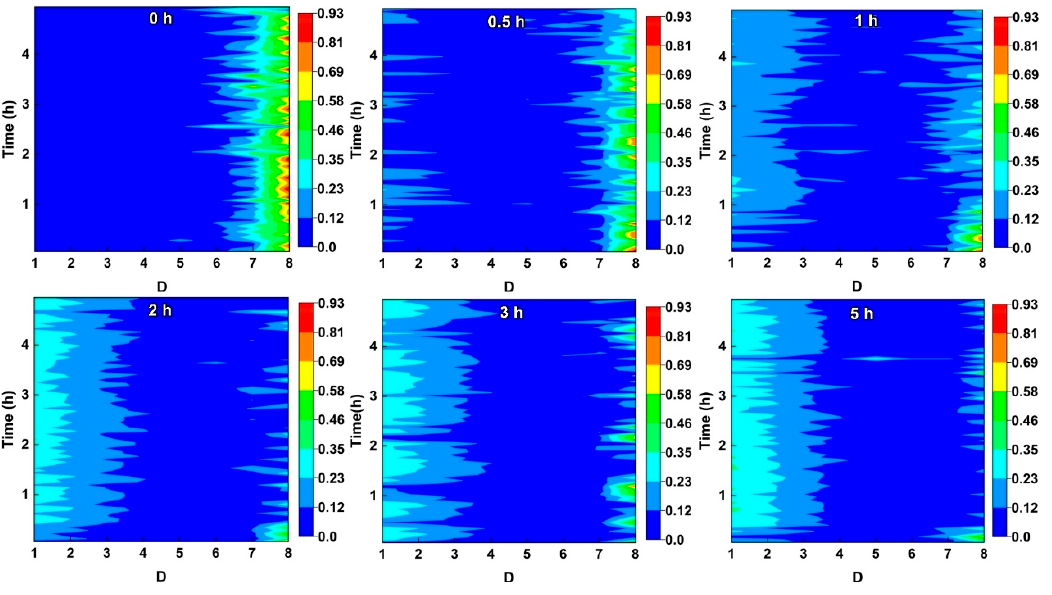
Figure 7. Energy distribution plots (EDP) for the current noise of NAB after different CE times.